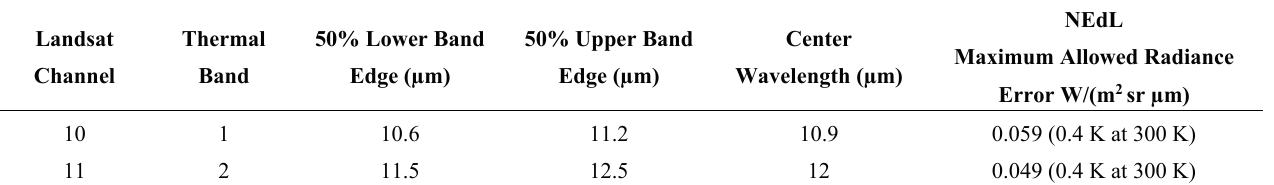
Table 1. TIRS band definitions and maximum allowed radiance error.